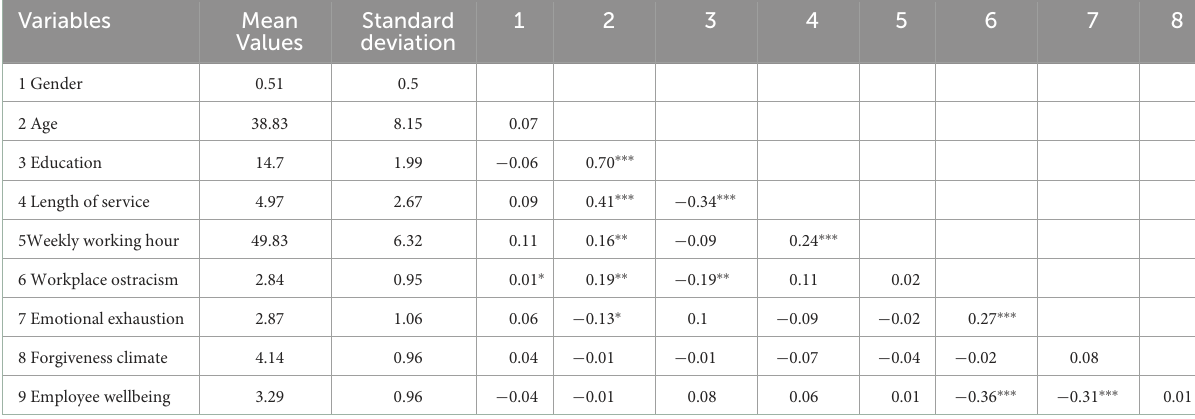
TABLE 2 Mean values, standard deviations, and correlation coefficients of variables ( N =